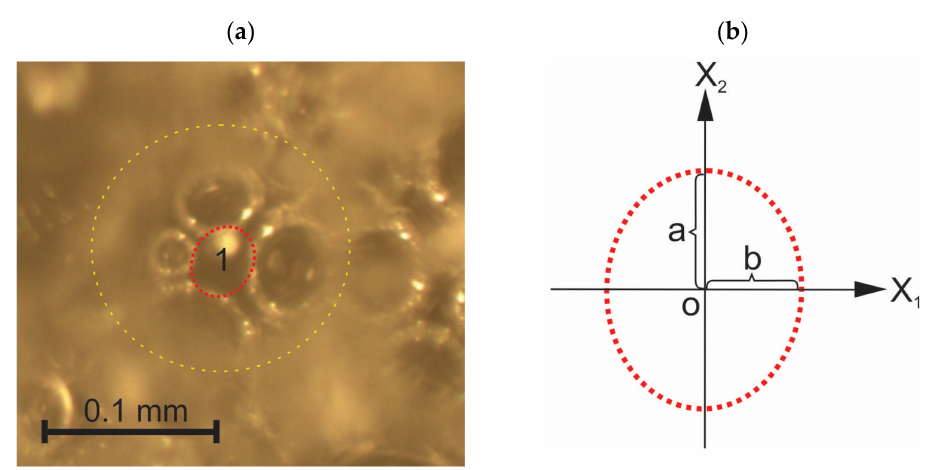
Figure 8. ( a ) An un-foamed volume “1” at the bottom of a cut bubble (yellow) and ( b ) projections “a” and “b” of the semi-axes of the model ellipse (red) on the cutting plane X 1 OX 2